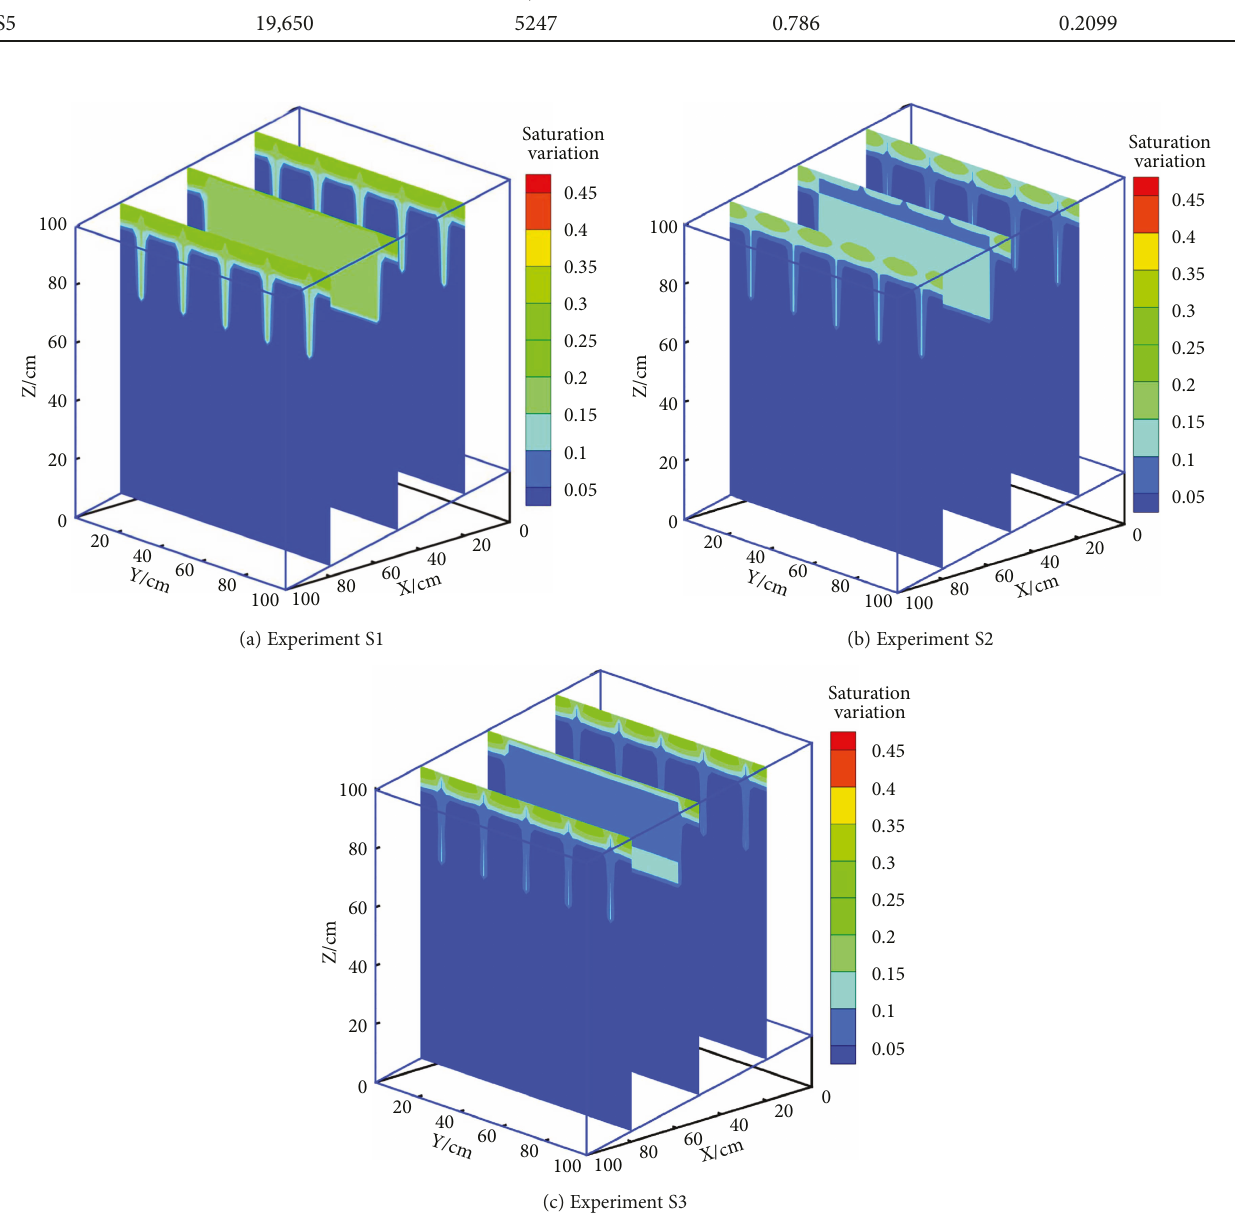
Figure 7: Simulated fl ow pattern of each experiment by the SMC model when t